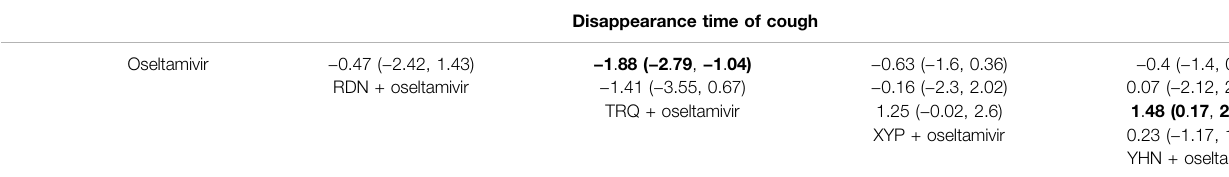
TABLE 2 | League table of disappearance time of